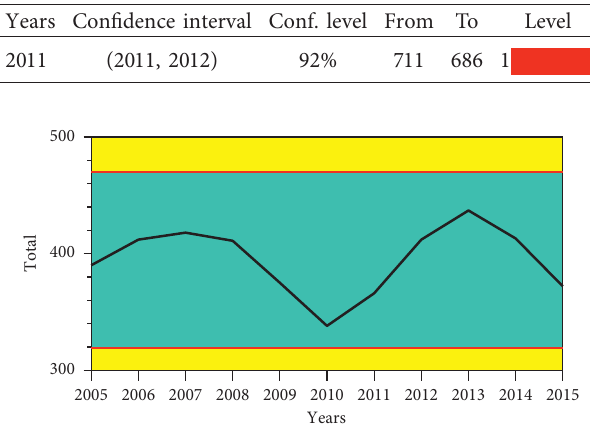
Figure 14: Northern Cape: background changes.